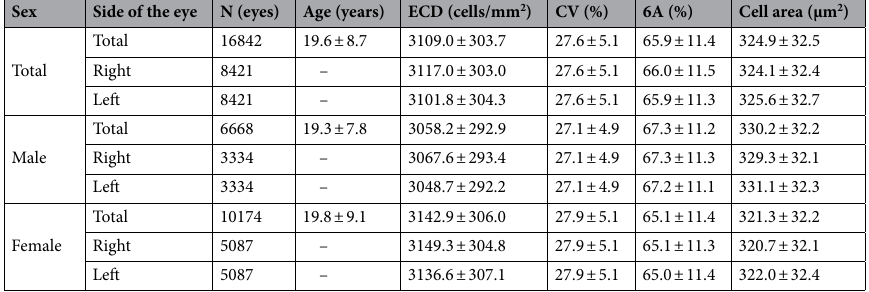
Table 1. Demographic data of ophthalmologically healthy Japanese eyes. ECD, corneal endothelial cell density; CV, coefficient of variation in cell area; 6A, appearance rate of hexagonal cells.